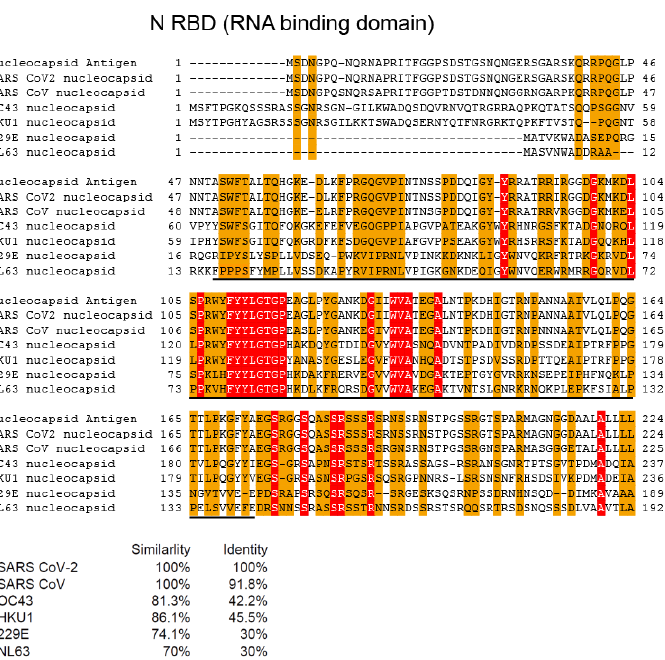
Figure 1. Multi-alignment analysis of the nucleocapsid RNA-binding domain of SARS-CoV-2, SARS-CoV, and alpha (229E and NL63) and beta (OC43 and HKU1) human coronaviruses. Similar- ity and identity are indicated as orange boxes and red boxes, respectively.